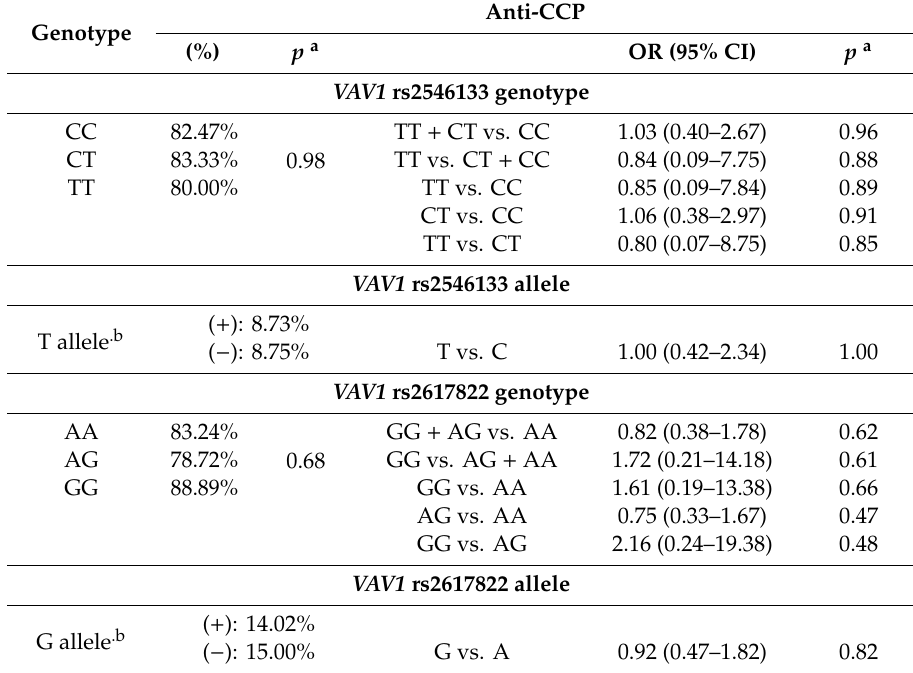
Table 5. Analysis of anti-cyclic citrullinated peptide (anti-CCP) antibodies in relation to VAV1 rs2546133 and rs2617822